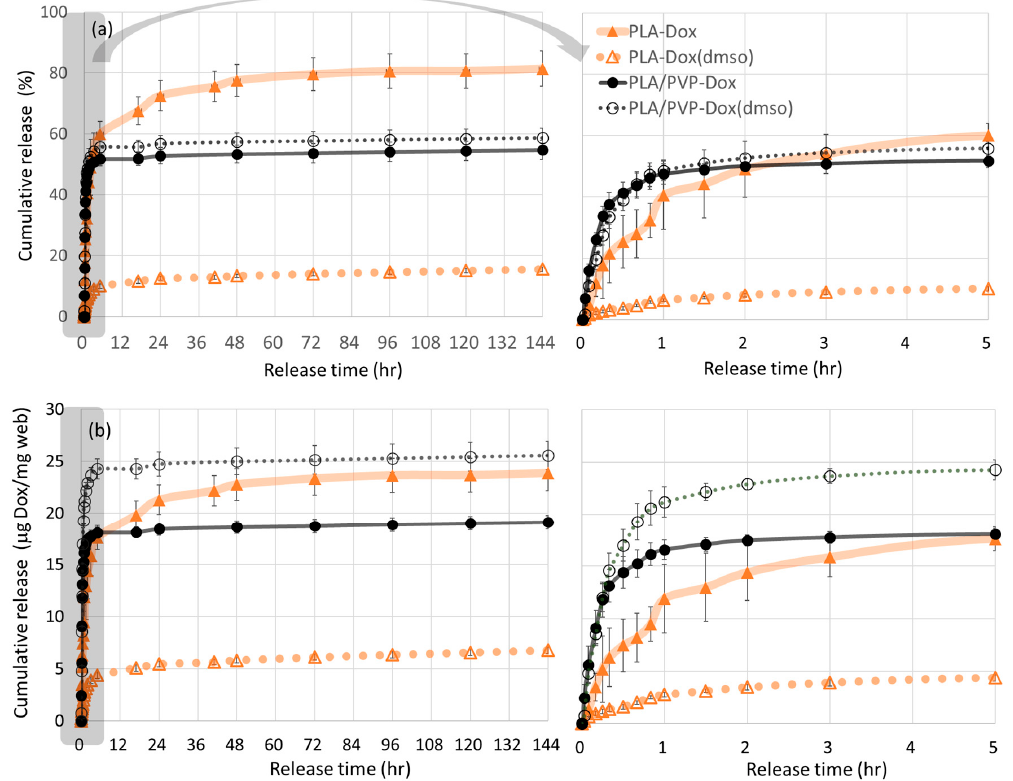
Figure 8. In-vitro 6-day release profile of doxorubicin from PLA and PLA/PVP webs. ( a ) Cumulative % release of Dox (left, release during 144 h; right, enlarged for 5 h); ( b ) cumulative released amount (mg) of Dox (left, release during 144 h; right, enlarged for 5 h).